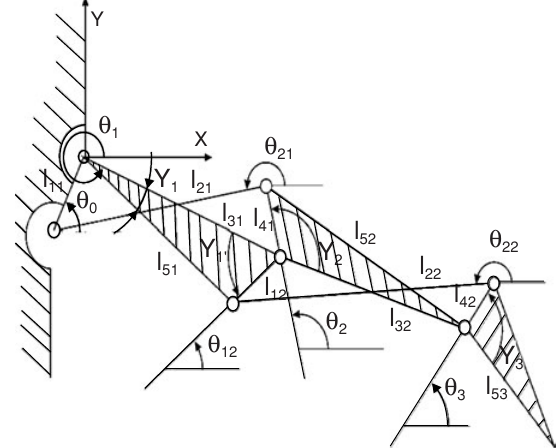
Figure 3 The kinematic diagram of the 1 d.o.f.